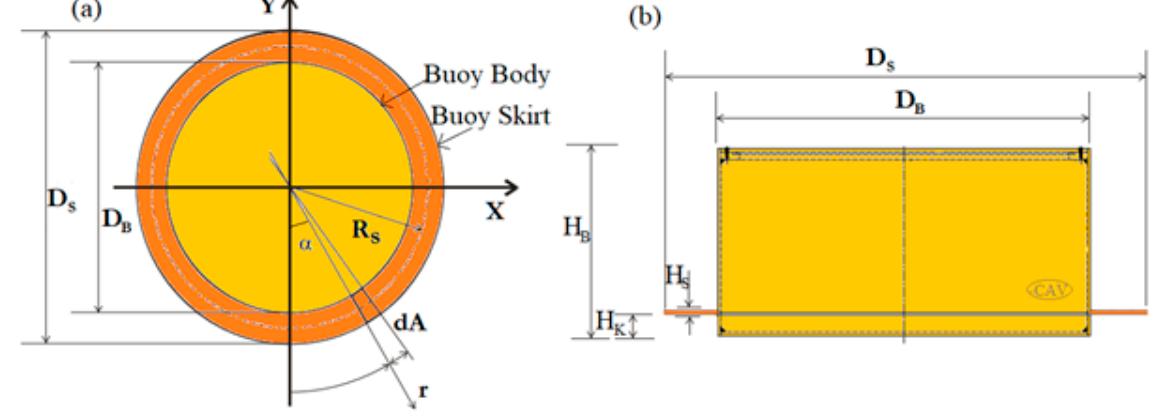
Figure 5. CALM Buoy Model with Skirt Dimension, showing ( a ) top plan view and ( b ) side